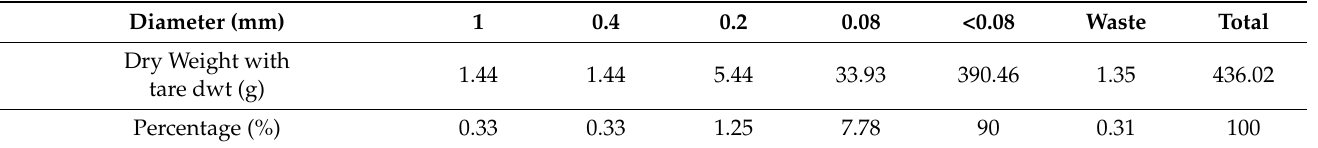
Table 1. Granulometric Analysis: